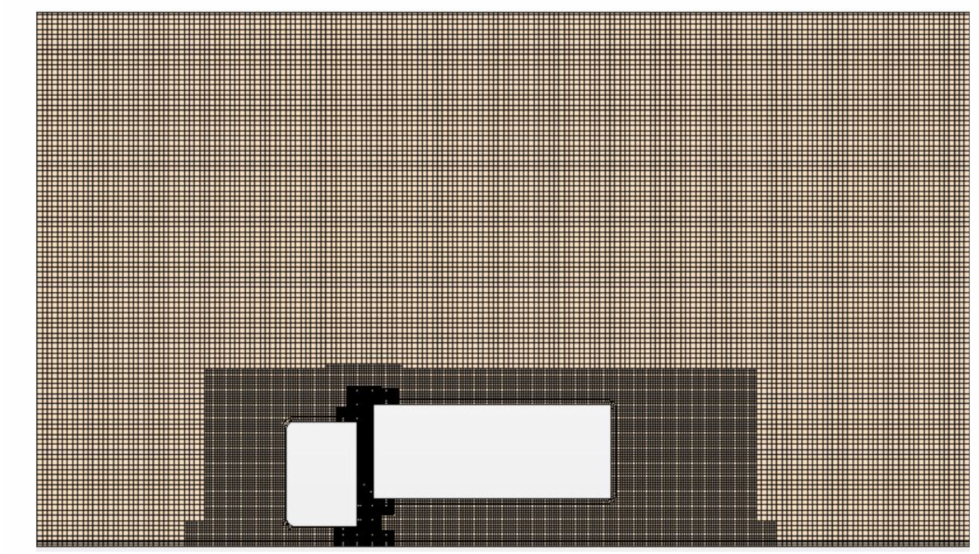
Figure 4. Side view of the mesh around the